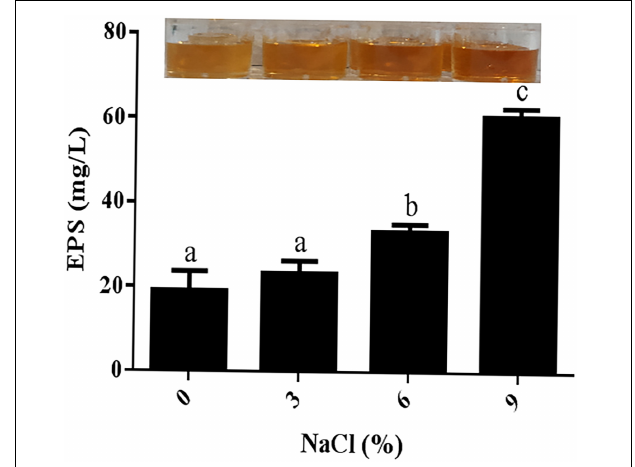
FIGURE 3 | Determination of extracellular polysaccharide levels produced by R. aquatilis JZ-GX1 at different salt concentrations. The vertical bars represent the standard deviations of the averages. One-way ANOVA was performed, and Duncan’s post hoc test was applied. Different letters indicate significant differences ( P < 0.05) among the treatments.